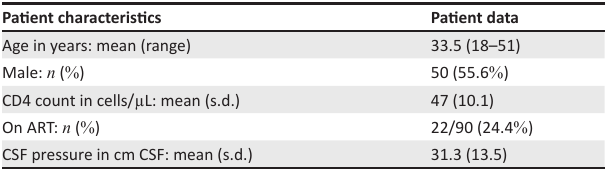
TABLE 2: Neuro-ophthalmological manifestations of cryptococcal meningitis in 90